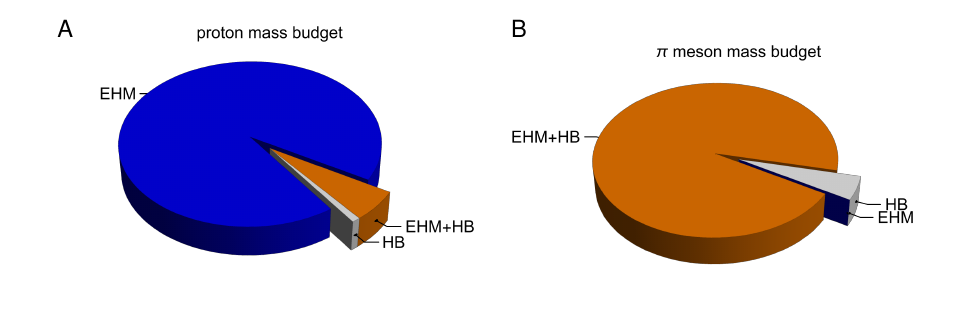
Figure 1. Mass budgets: A –proton; B –pion. Each is drawn using a Poincaré invariant decomposition, with the numerical values listed elsewhere [26, Table 1]: HB – contribution owing solely to the Higgs boson; EHM – contribution from emergent hadron mass; EHM + HB – mass generated by constructive interference between these two sources of